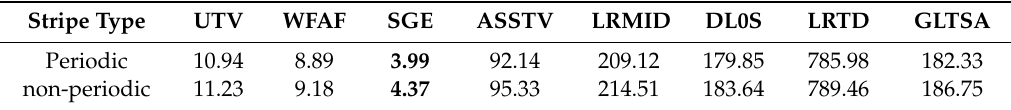
Table 4. Comparison of running time on WDCM dataset with periodic and non-periodic stripe (in